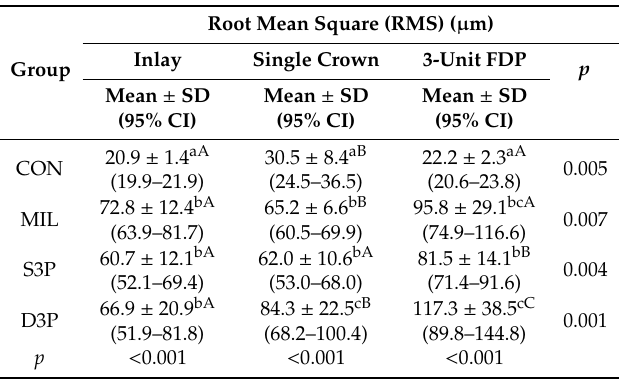
Table 2. The trueness of three prepared teeth in inlay, single crown, and three-unit fixed dental prostheses (FDP).